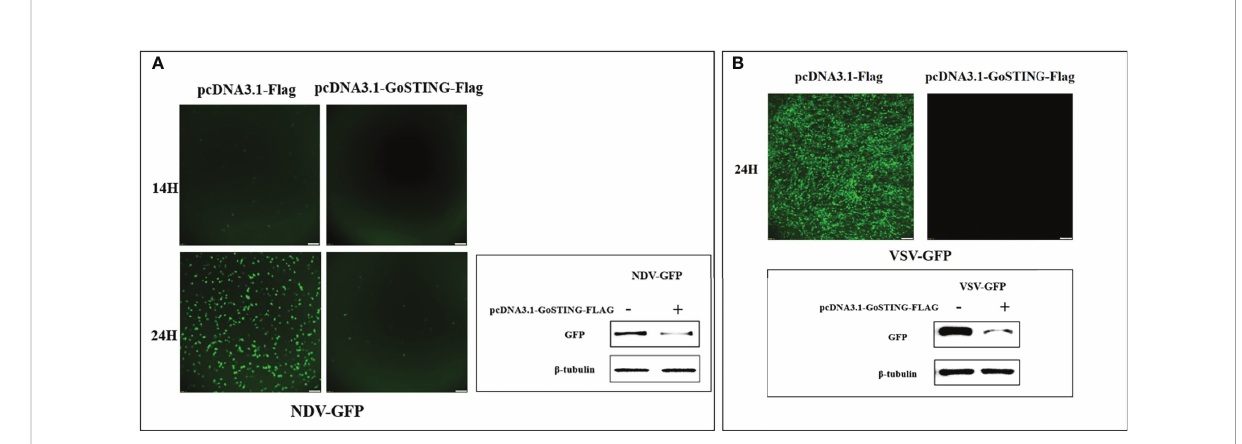
FIGURE 6 GoSTING inhibits viral yield. (A) Viral fl uorescence in DF-1 cells transfected with pcDNA3.1-Flag or pcDNA3.1-GoSTING-Flag and infected with NDV-GFP at 0.01 MOI. Error bars represent standard deviations and Western blots for the expression of the NDV-GFP. (B) Viral fl uorescence in DF-1 cells transfected with pcDNA3.1-Flag or pcDNA3.1-GoSTING-Flag and infected with VSV-GFP at 0.01 MOI. Error bars represent standard deviations and Western blots for the expression of the VSV-GFP.